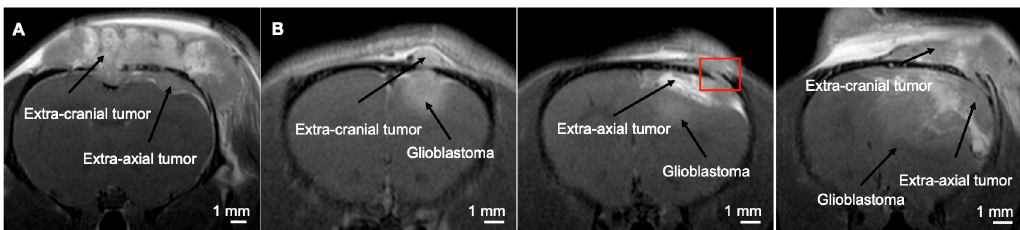
S1 Table. Overview of cause of death for all rats. Rats were immediately euthanized when clinical and behavioral signs were observed. S2 Table. GB volumes. Tumor volumes were measured on CE-T1w MR images by manually outlining the hyperintense regions on individual